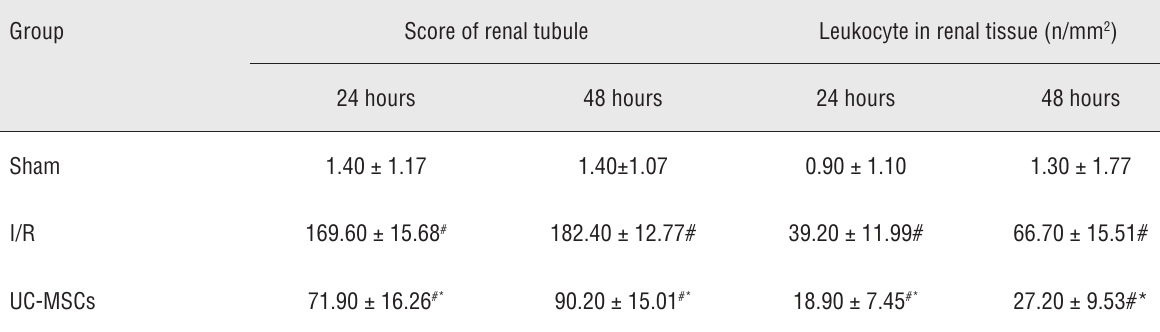
Table 1 - Renal tubule scoring and renal tissue leukocyte counting in different groups.